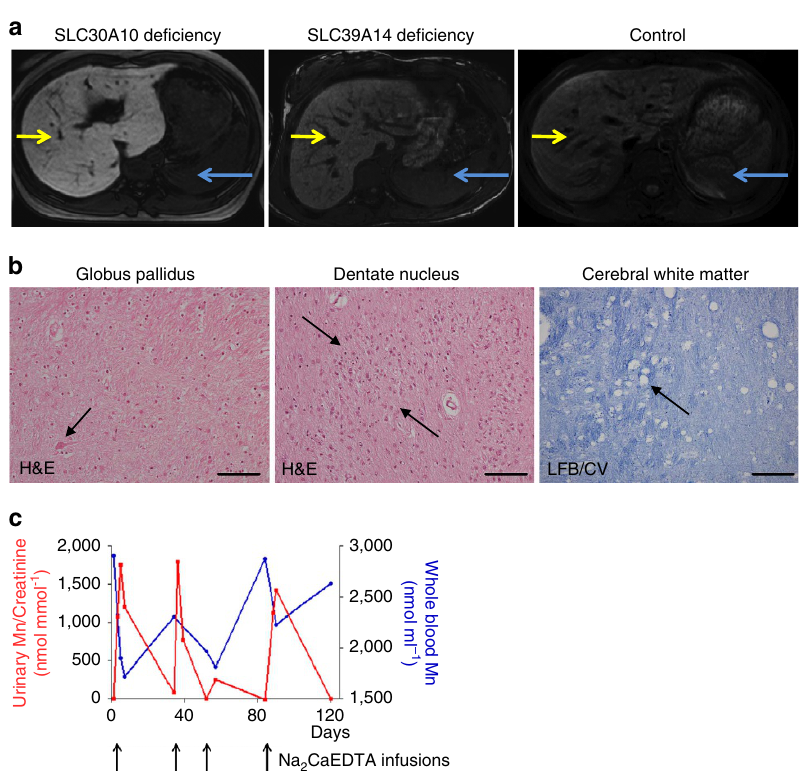
Figure 2 | SLC39A14 deficiency causes hypermanganesemia and neurodegeneration that responds to chelation treatment with Na 2 CaEDTA. ( a ) Liver MRIs of a patient with SLC30A10 deficiency, individual E-II-2 with SLC39A14 mutations and a control subject. The extensive signal hyperintensity on T1-weighted imaging caused by hepatic Mn deposition in SLC30A10 deficiency is absent in individual E-II-2. There is only a subtle degree of T1- hyperintensity when compared with the control subject. Signal intensity of the liver (yellow arrow) was compared with that of the spleen (blue arrow). ( b ) Brain histology from post-mortem examination of subject D-II-1. Sections of globus pallidus and dentate nucleus stained with hematoxylin and eosin (H&E) show marked neuronal loss with only occasional remaining neurons (arrow) accompanied by reactive astrocytosis (shown within the ribbon of the dentate nucleus (between arrows)). Scale bar, 100 m m. Luxol fast blue/cresyl violet stain of a section of the cerebral white matter demonstrates patchy loss of myelin associated with coarse vacuoles (arrow). Scale bar 200 m m. ( c ) Graph showing whole-blood Mn levels and urinary Mn excretion over four courses of Na 2 CaEDTA treatment in individual E-II-2. Arrows indicate timing of Na 2 CaEDTA courses (day 1, 34, 52 and 84). Administration of Na 2 CaEDTA causes a significant increase in urinary Mn excretion (red) accompanied by a drop in whole-blood Mn levels